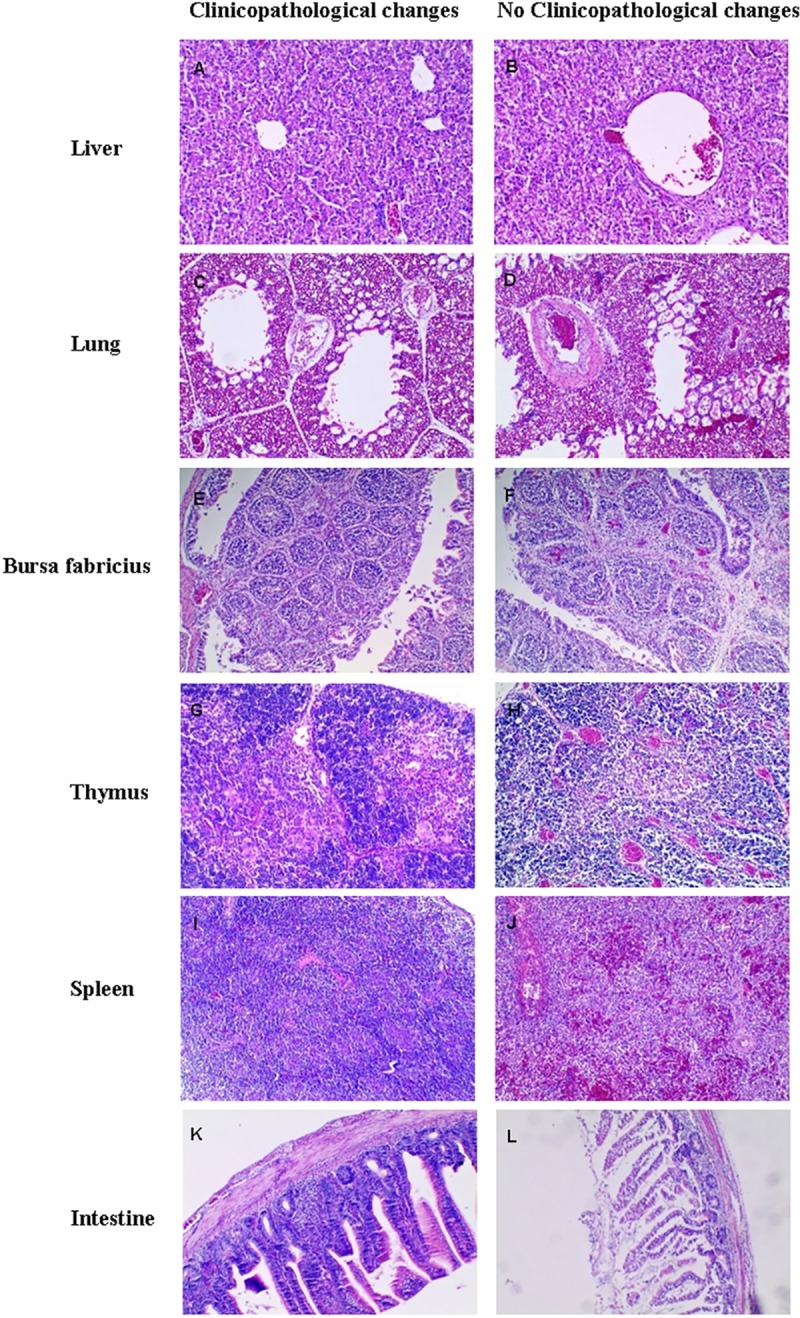
The histopathology changes of chicks.After acute dead period, the histopathology changes of the dead and euthanized chicks which observed clinicopathological changes from all groups showed the similar results. A. Liver from no clinicopathological changes chicks randomly. No lesion. B. Liver from presenting clinicopathological changes chick randomly. Cell swelling, steatosis, moderate to severe inflammatory cell infiltration were observed. C. Lung from no clinicopathological changes chicks randomly. No significant lesion. D. Lung from presenting clinicopathological changes chick randomly. Lymphoid infiltration, cellulose abounding in the alveolar cavity and slightly congestion. E. Bursa fabricius from no clinicopathological changes chicks randomly. No significant lesion. F. Bursa fabricius from presenting clinicopathological changes chick randomly. Unclear the tissue boundary, exfoliation of mucosal epithelium and interstitial connective tissue proliferation. G. Thymus from no clinicopathological changes chicks randomly. No significant lesion. H. Thymus from presenting clinicopathological changes chick randomly. Unclear the tissue boundary, moderate and severe congestion I. Spleen from no clinicopathological changes chicks randomly. No significant lesion. J. Spleen from symptomatic chick randomly. Unclear the tissue boundary, mild and moderate congestion, a large number of blood red cells were found in splenic sinusoid. K. Small intestine from no clinicopathological changes chicks randomly. No significant lesion. L. Small intestine from presenting clinicopathological changes chick randomly. Intestinal mucosal edema and mild and moderate intestinal villi shedding.